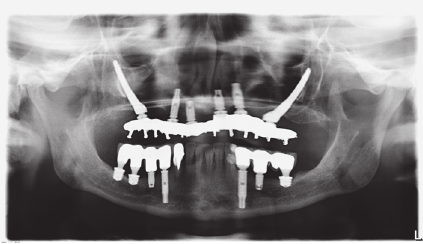
Figure 10: Panoramic radiograph at 2 years of